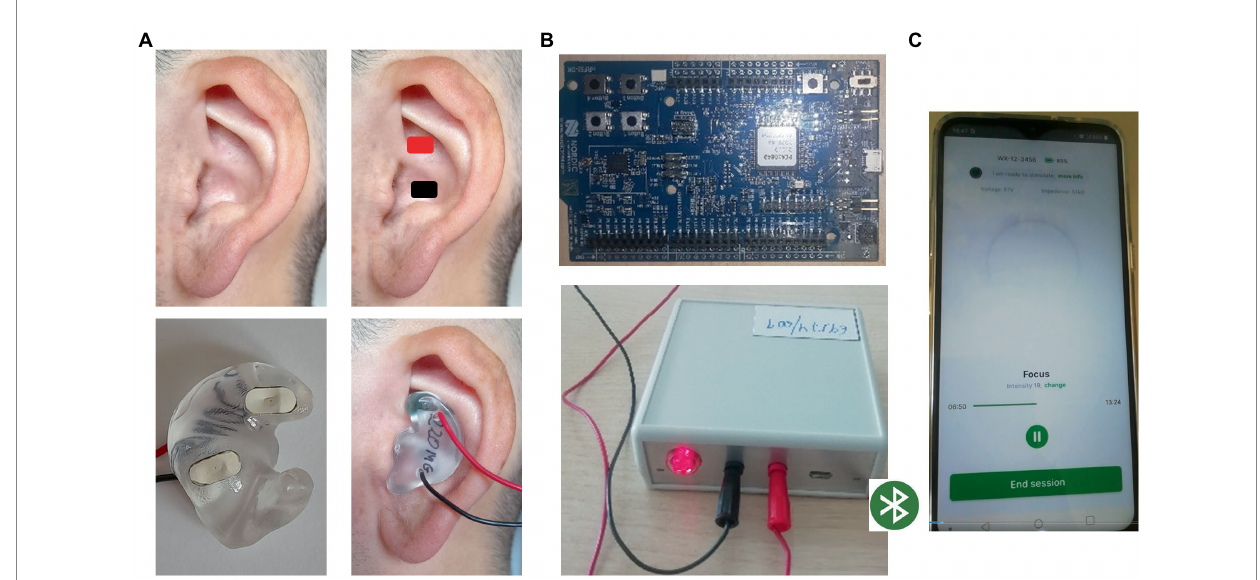
FIGURE 1 taVNS system. (A) Customized auricular device with stimulating platinum electrodes over cymba and cavum conchae physically connected to B; (B) electrical stimulus generator connected by Bluetooth to C; (C) stimulation control module in a smart phone app. That allowed to control the stimulating parameters.